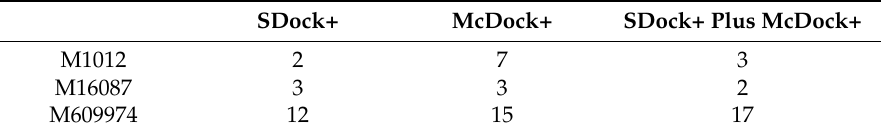
Table 1. Rank order of known compounds using each method. Results are shown of testing docking protocols.